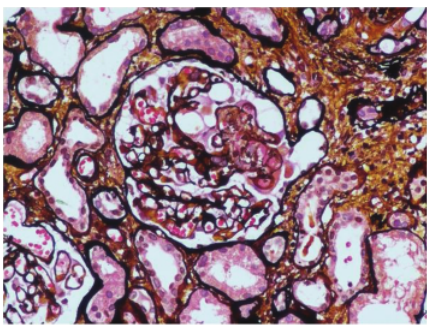
Figure 2: Section of glomerulus with methenamine silver staining showing circumferential cellular crescent with fibrinoid necrosis and leukocytic exudation.